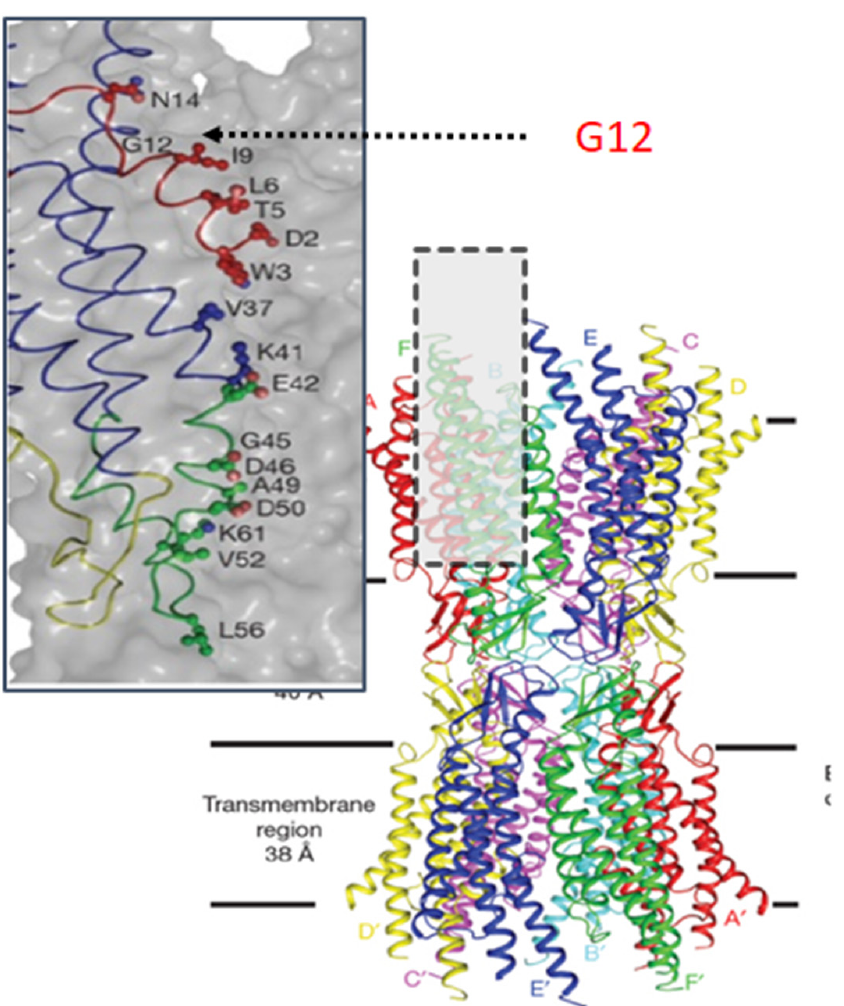
Figure 3. Structure of the Cx26 gap junction channel in ribbon representation. Twelve connexin subunits form a pore that spans two cell membranes and the extracellular space. Inset: Pore structure highlighting location of G12 with the amino terminus (red) which folds into the pore. Modified from [40].